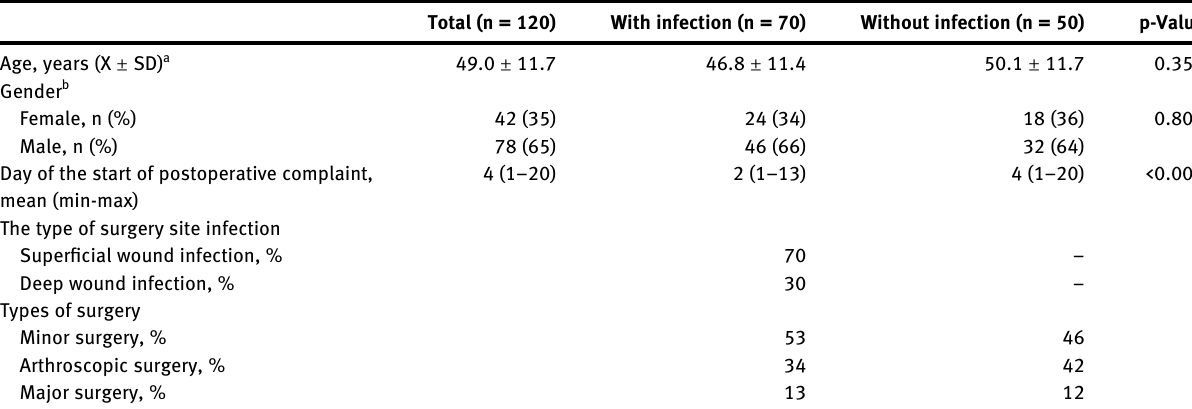
Table  : Comparison of demographical measurements in patients with and without infection.